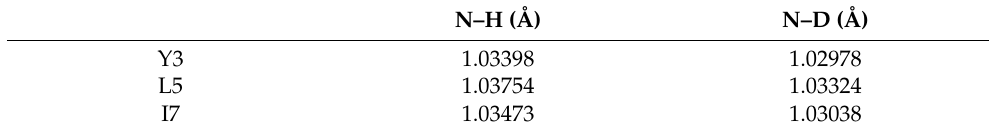
Table 1. Average bond lengths a of N–H and